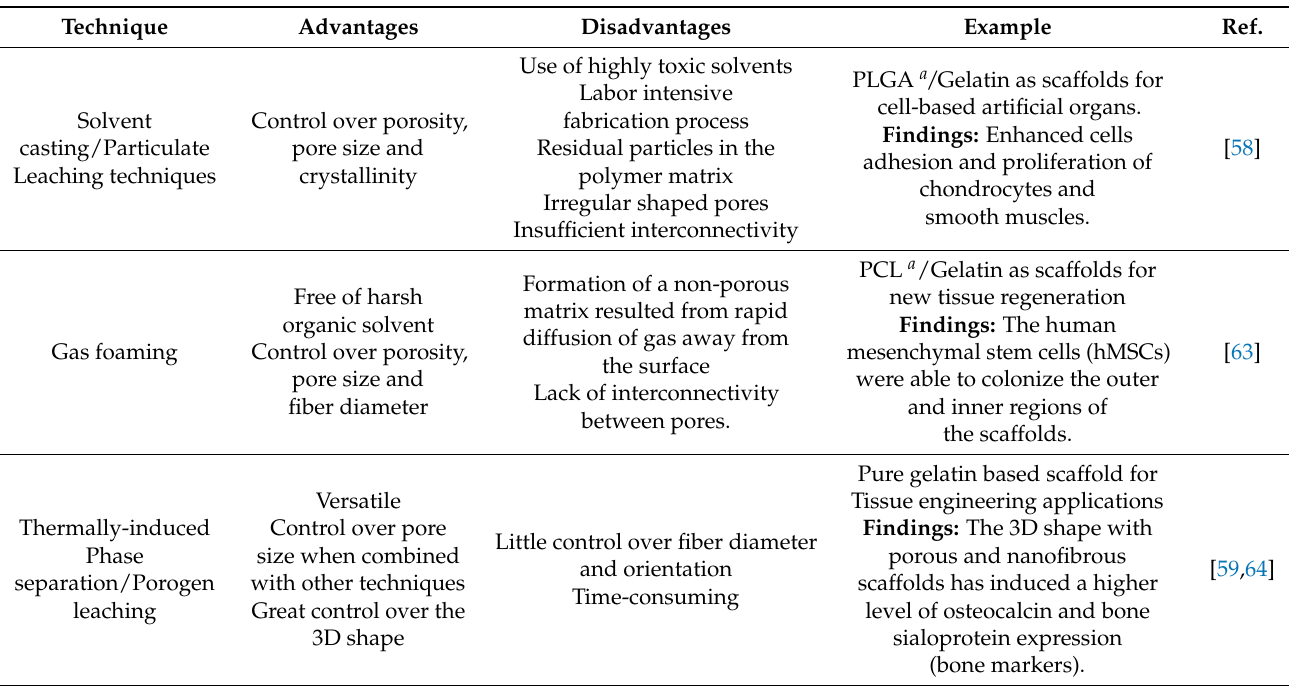
Table 1. Summary of common techniques to fabricate nanofibrous scaffolds for tissue engineering applications. Technique Advantages Disadvantages Example